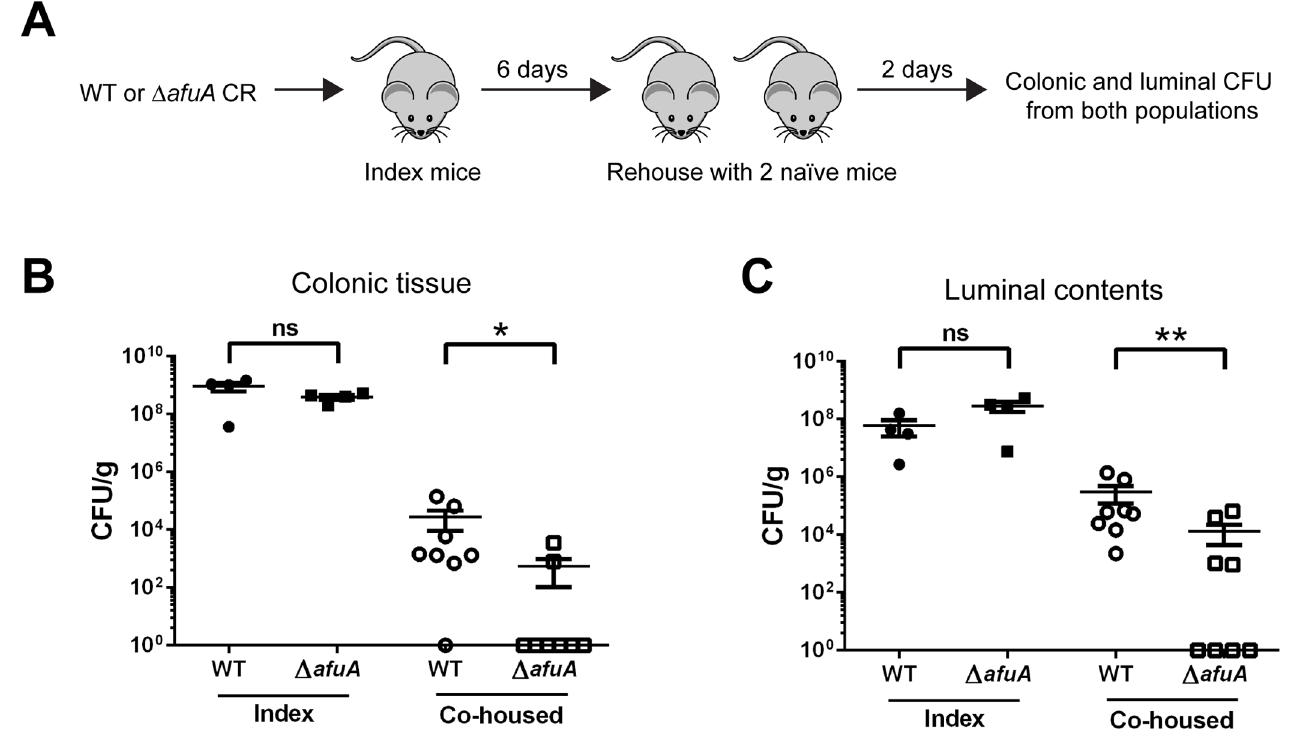
Fig 7. C . rodentium requires AfuA for efficient host-to-host transmission. (A) Infection schematic for quantification of C . rodentium host-to-host transmission. C57BL/6 index mice were orally infected with C . rodentium WT or Δ afuA . At 6 dpi, index mice were added to a cage containing two na ï ve mice and 48h post-exposure, bacterial luminal and colonic burdens determined. (B, C) Ability of C . rodentium WT or Δ afuA to transmit between index and co- housed C57BL/6 mice. Bacterial colonic (B) and luminal (C) burdens were determined for both index and co-housed mice. Data were combined from two independent experiments. Each symbol represents one animal (n = 4 (index), 8 (co-housed) for each infection). The median is indicated. * = p < 0.05.